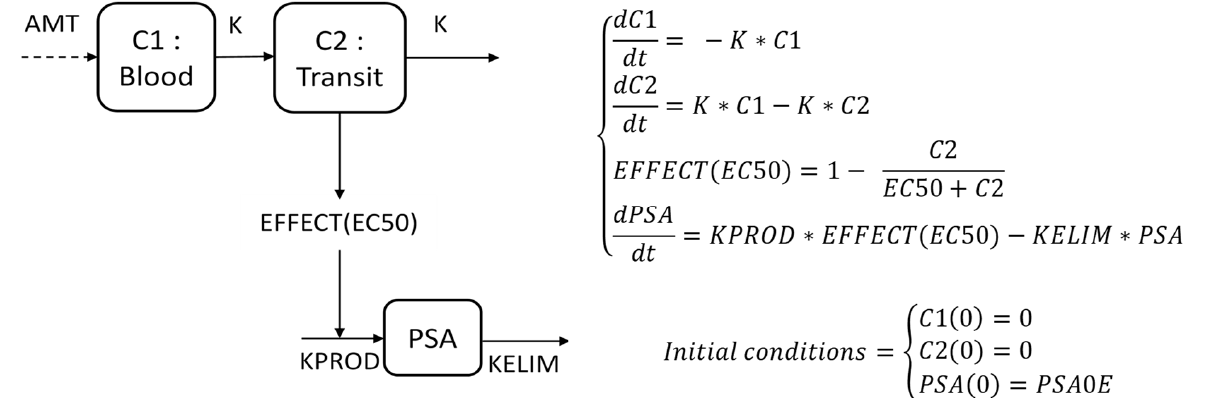
Figure 1. Description of the semi-mechanistic PSA kinetic model. Differential equations and com- partment representation of the K-PD PSA kinetic model. AMT (Amount): dose administered, fixed to 1, due to missing pharmacokinetic data. C1 and C2: Concentrations of administered treatment and transit compartment. PSA: PSA compartment. EC50: Treatment concentration required to obtain 50% of the maximal effect (arbitrary unit). K: treatment kinetic rate constant (day − 1 ). KPROD: PSA production rate (ng ∙ ml –1 ∙ day –1 ). KELIM: PSA elimination rate constant (day − 1 ). EFFECT: Indi ‐